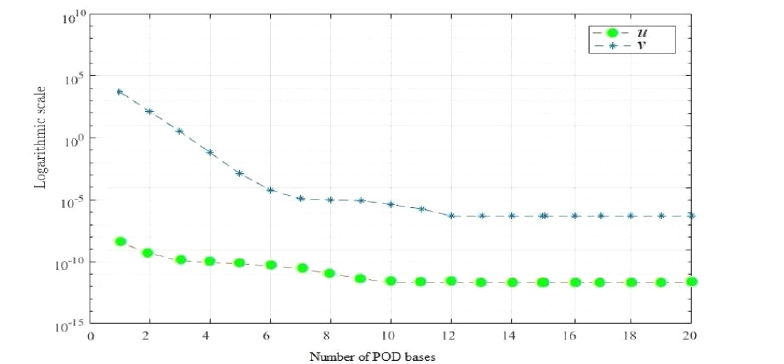
Figure 4. The errors between the CNMFE and RDR-CNMFE solutions with different POD bases at t =